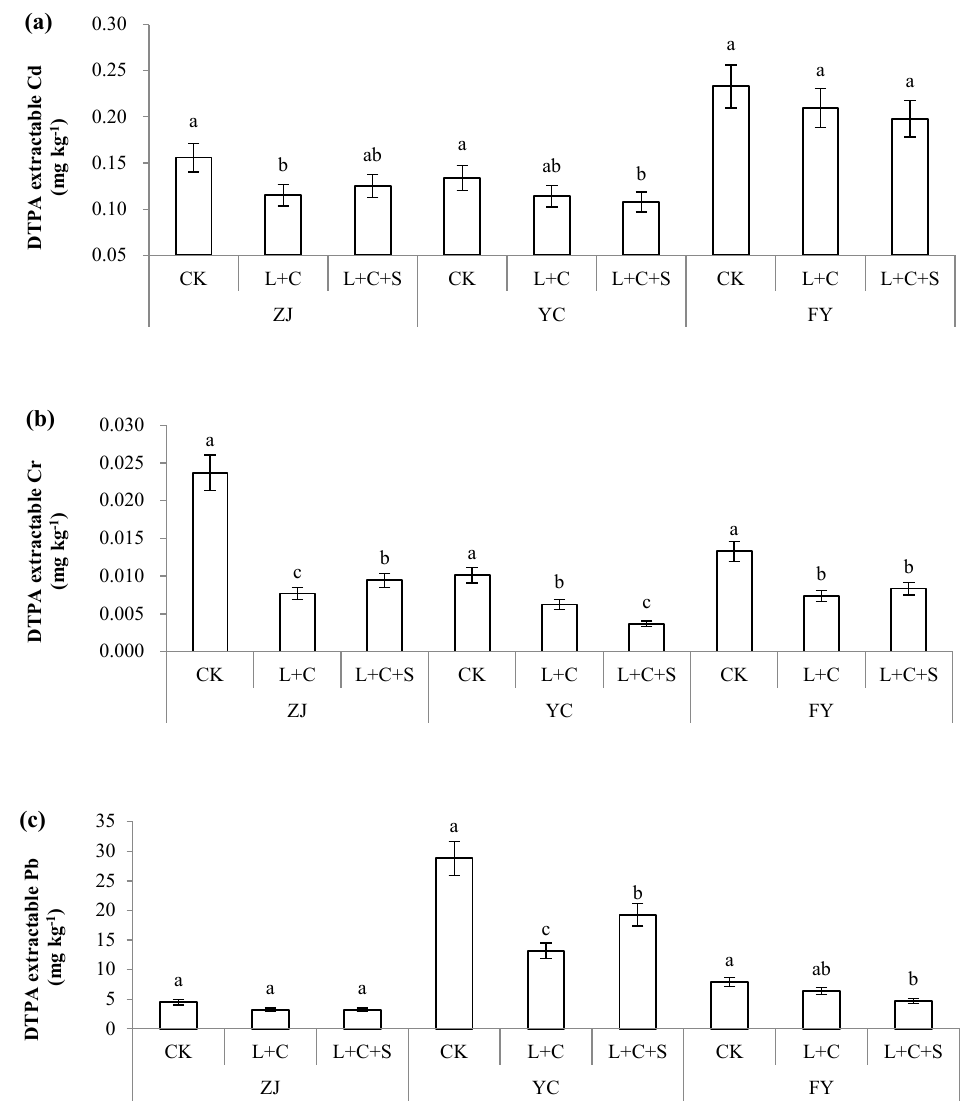
Figure 3. DTPA-extractable Cd ( a ), Cr ( b ), and Pb ( c ) in paddy soil treated by control with no passivators (CK), 9000 kg ha − 1 of lime + biochar with a rate of 1:1 (L + C), and 9000 kg ha − 1 lime + biochar + sepiolite with a rate of 1:1 (L + C + S). Values (means ± SD, n = 3) with different letters indicate significant differences between objects in the respective sites (separately for ZJ (Zhuji), YC (Yuecheng), or FY (Fuyang)).